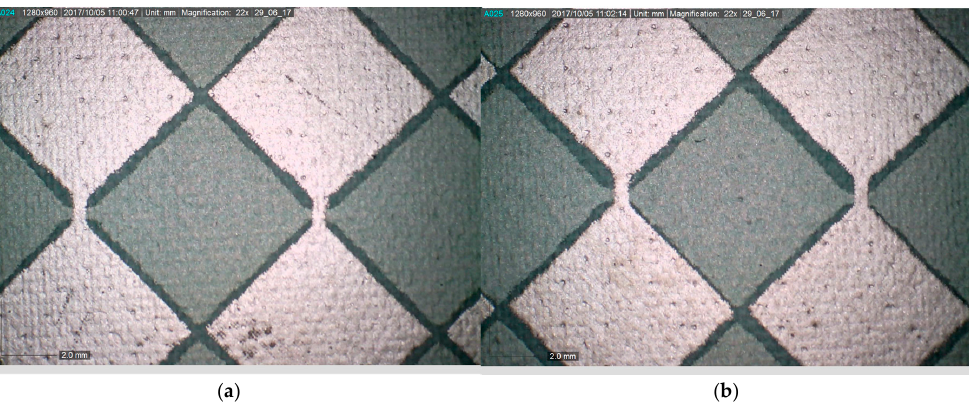
Figure A6. ( a ) Dielectric for a mesh of 175 and three layers; and ( b ) dielectric for a mesh of 137 and two layers.